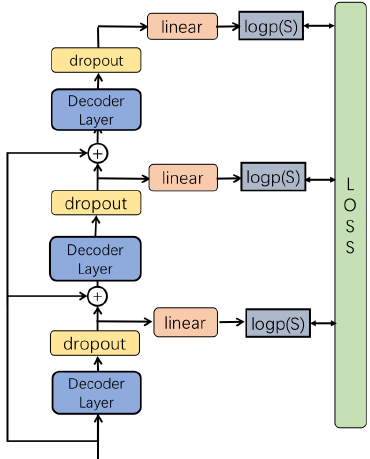
Figure 2. This figure shows the structure of the proposed multi-level supervision. We add a linear layer for every output, this makes the Transformer can generate sentence at every layer. At the training time, we train the model with all